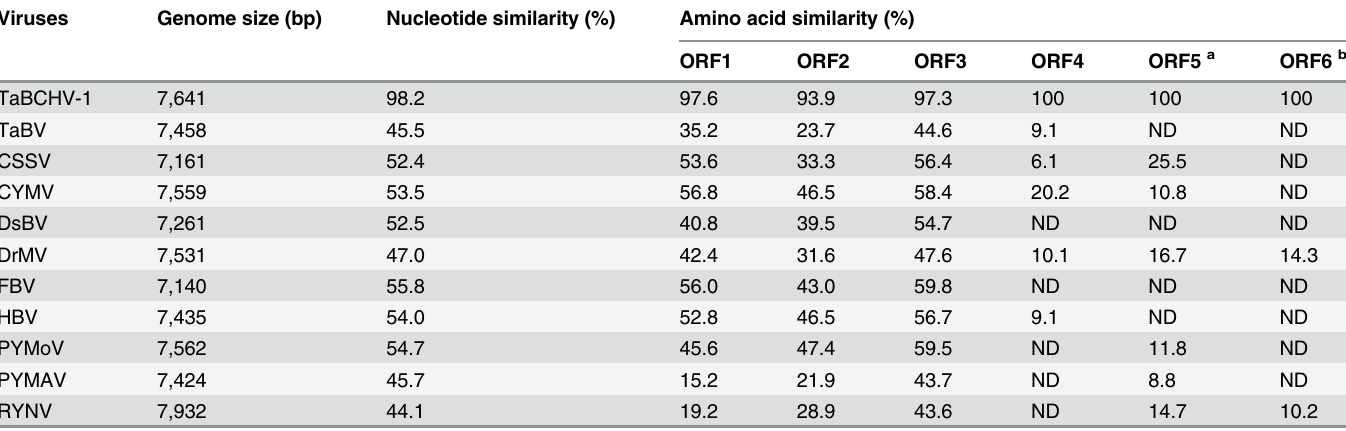
Table 1. Comparison of the nucleotide of genomes and amino acid sequences of six ORFs of TaBCHV-2 with the corresponding sequences of TaBCHV-1 and other badnaviruses.